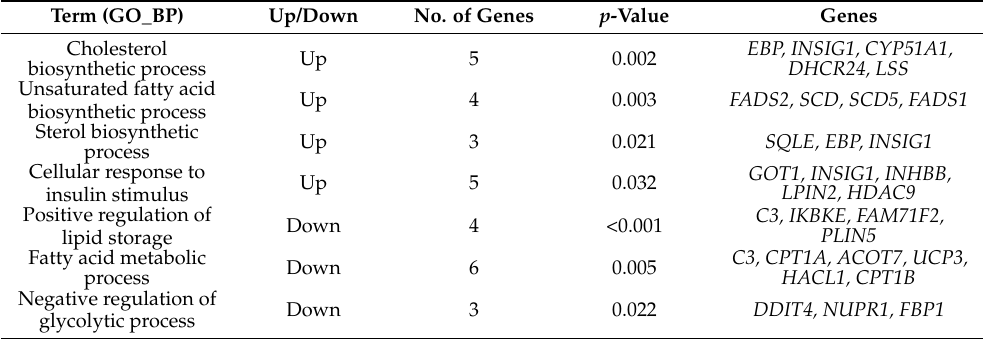
Table 7. Enriched biological processes ( p < 0.05) highlighted in over-representation analysis of up- and down-regulated differentially expressed genes identified in G2 at